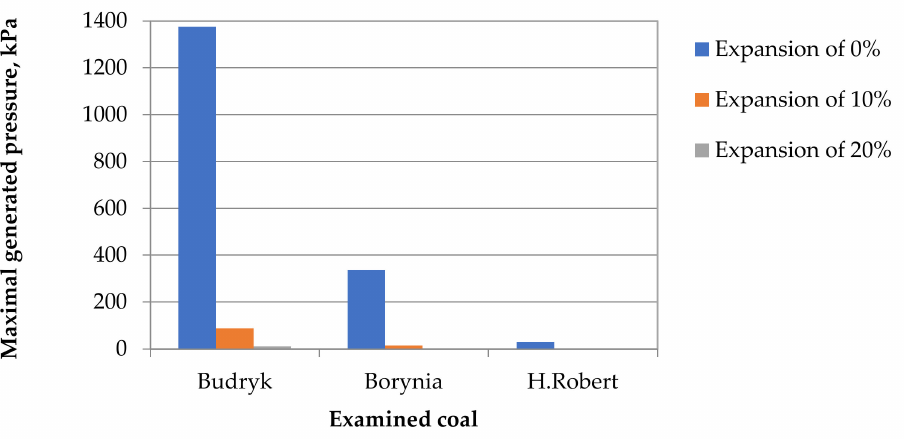
Figure 5. Impact of the expansion rate of the examined coal samples on the generated pressure (grain size fraction: 0–5 mm).